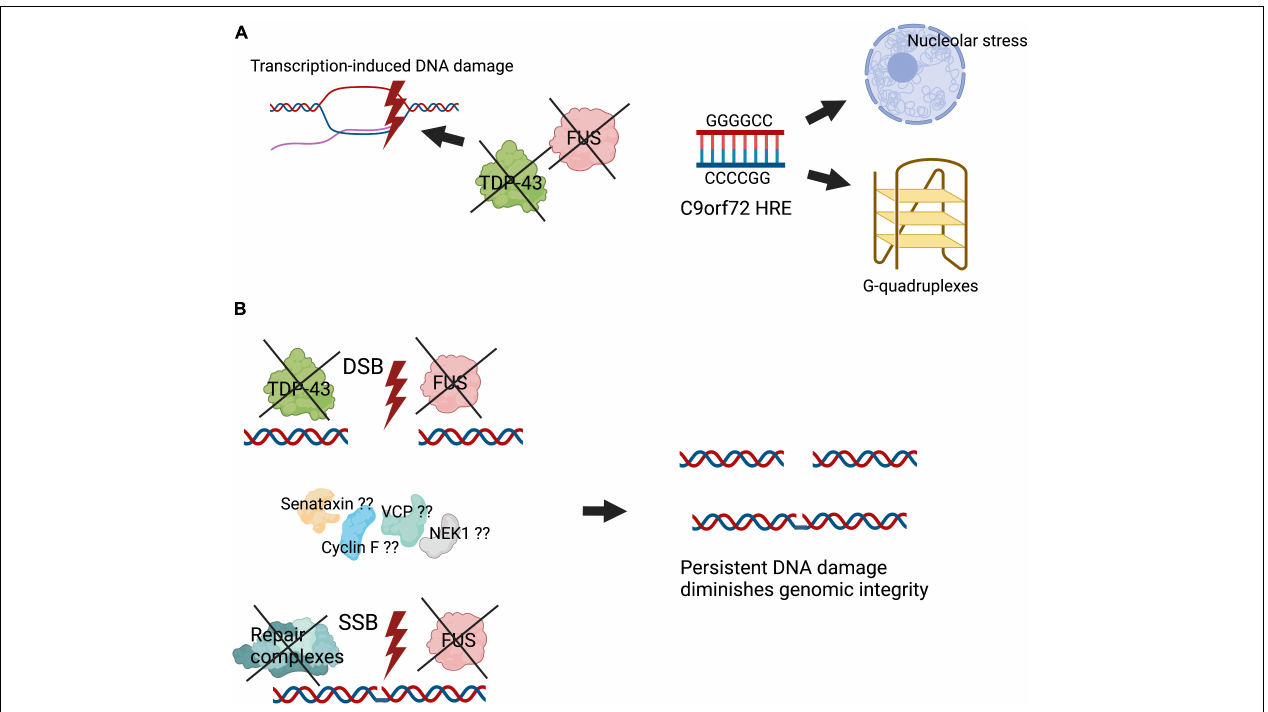
FIGURE 3 | Illustration summarising how DNA damage induces neurodegeneration in ALS. Genomic integrity is essential for maintenance of cellular homeostasis. However, defective DNA repair processes diminish genomic integrity, leading to mutations and cell death. (A) The presence of specific mutations in ALS, including the C9orf72 hexanucleotide repeat expansion, induces the formation of aberrant DNA structures such as R loops, inducing stress in the nucleolus. In addition, key DNA repair proteins, including TDP-43 and FUS, are dysfunctional and form aberrant pathological forms in ALS, causing transcription-induced DNA damage. (B) Inefficient binding of TDP-43 and FUS at sites of DNA damage, as well as impairment of their activities in DNA repair in their pathological forms, inhibit the assembly or stabilisation of key DNA repair complexes. Putatively, other proteins associated with ALS, including mutant forms of senataxin, VCP, cyclin F, and NEK1, may also lead to deficiencies in DNA repair. These events lead to accumulation of DNA damage and impaired genomic integrity, which triggers